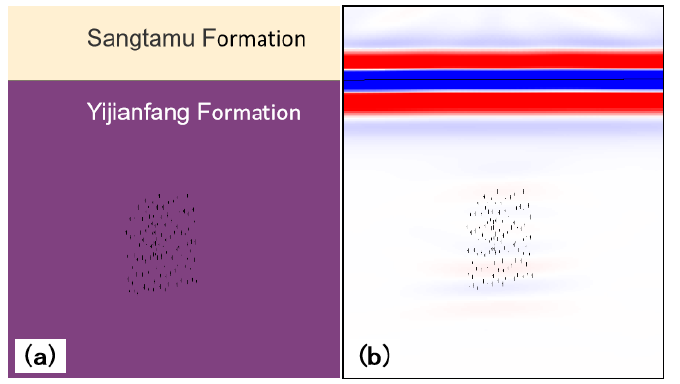
Figure 7. A geological model and forward modeling section of a vuggy reservoir. The black dots are vugs and are designed as an aggregate. The single vug size is less than 1 m. ( a ) the vuggy reservoir geologic model; ( b ) the profile of vugs model superimposed on forward simulation results.